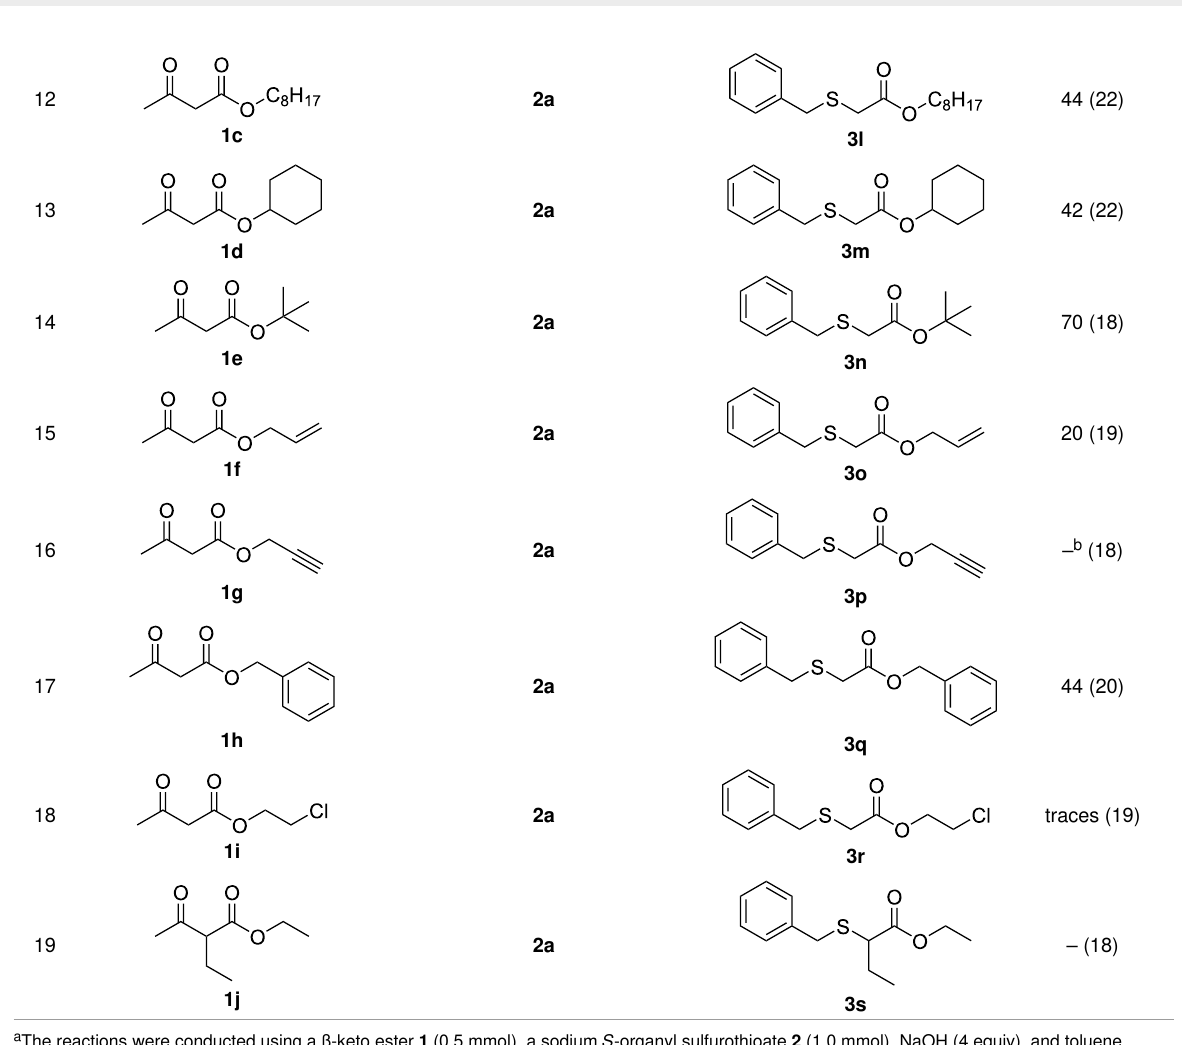
Table 2: Substrate scope for the synthesis of the α -organylthio esters 3 . a